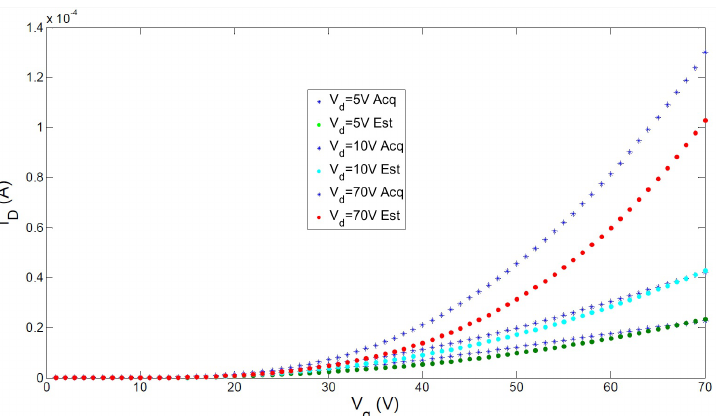
Figure 11. Comparison between acquired transfer curves and those estimated by means of mono- objective evolutionary